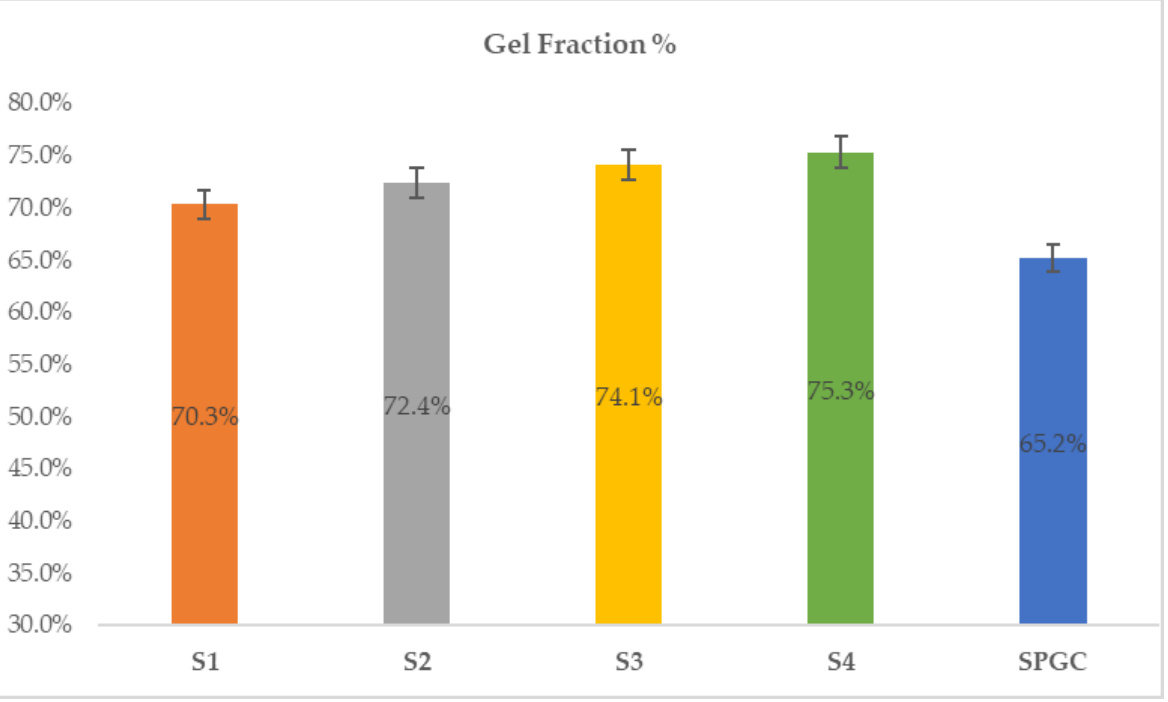
Figure 7. Comparison of the starch-based film (SPGC) and the samples (S1–S4) with nZnO gel fraction percentage.